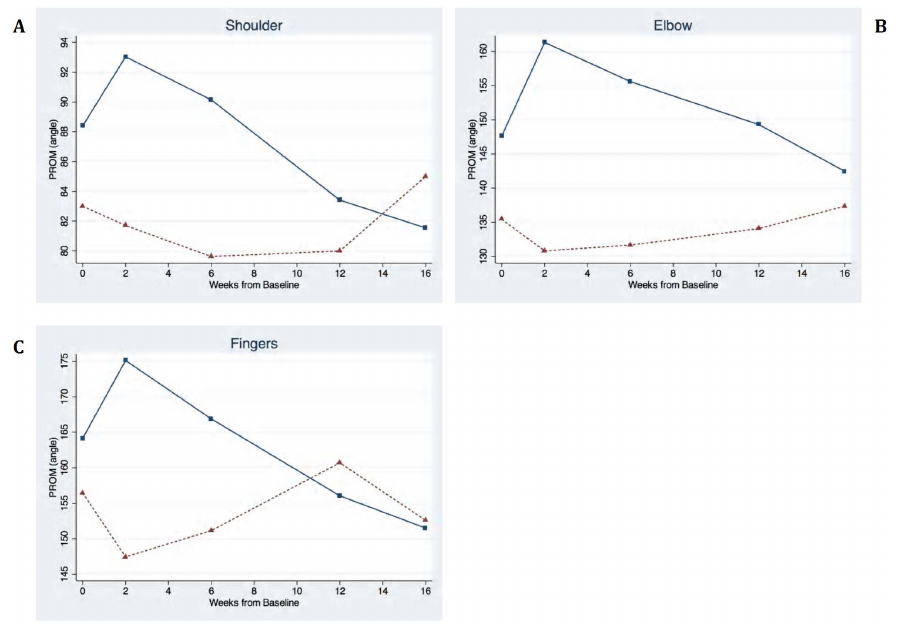
Fig. 3. Passive range of motion (PROM) following Incobotulinumtoxin A injections ( % ) and Placebo ( D ) treatments for: A) Shoulder B) Elbow C) Fingers.